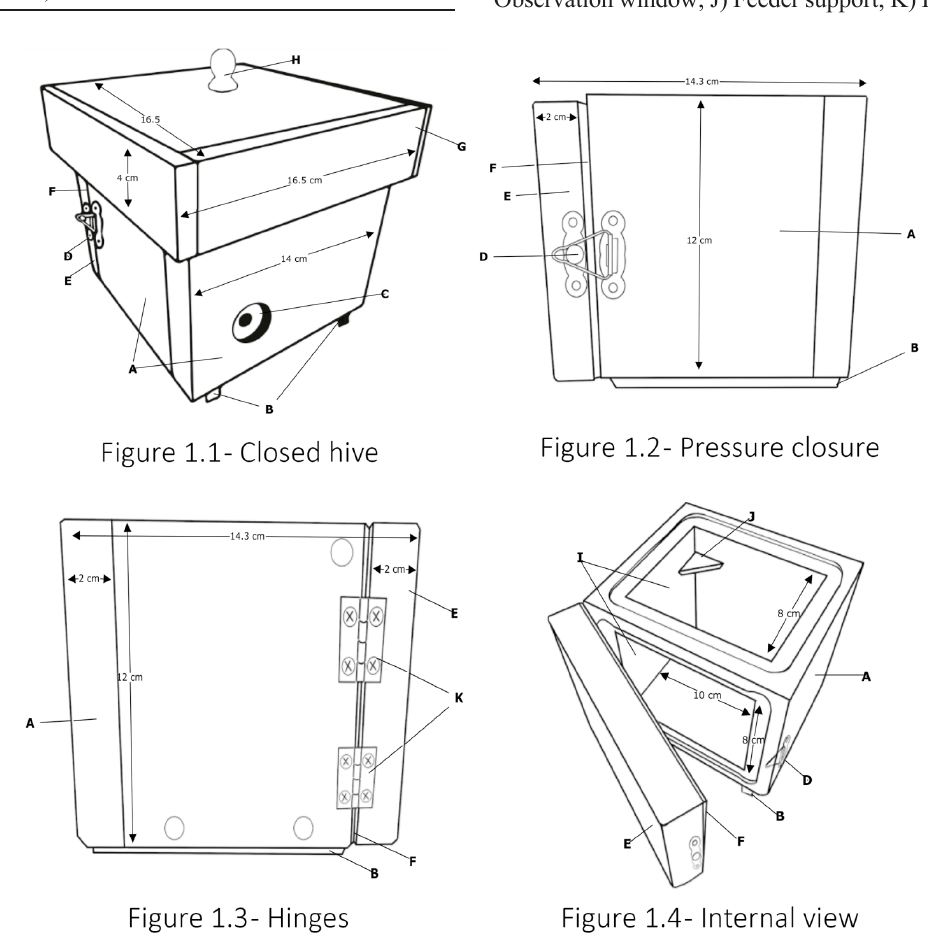
Fig 1 . SOS Abelhas sem Ferrão (Stingless bees ) Hive Model (Illustrations by Paula